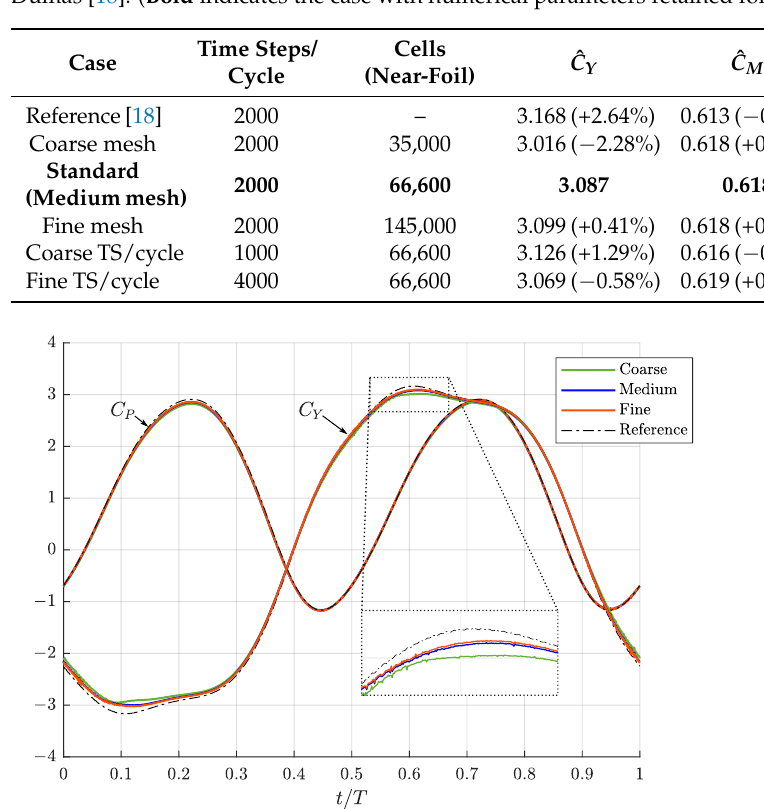
Figure 5. Comparison of instantaneous C P and C Y for 3 mesh resolutions and with Kinsey and Dumas [18] reference, for case f ∗ = 0.16, θ 0 = 75 ◦ , H 0 = c , φ = 90 ◦ , x p = c /3 (without